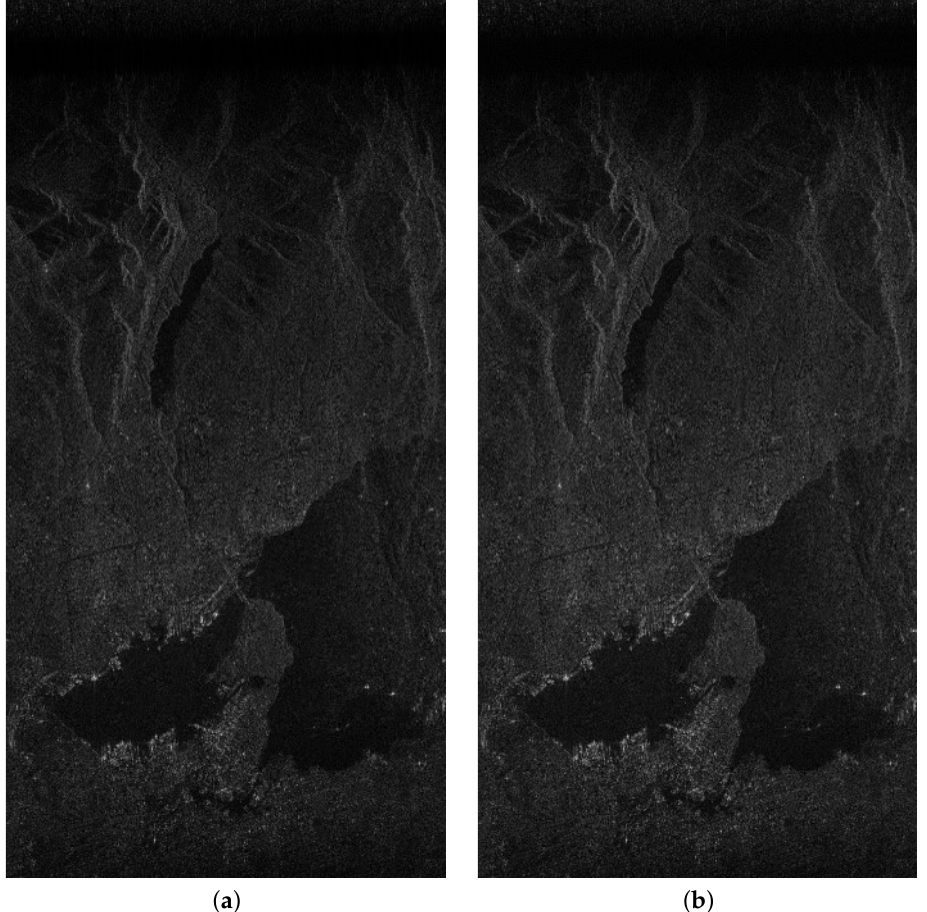
Figure 12. SAR images derived using ( a ) ARM Cortex-A53-based SW and ( b ) the proposed FPGA-based